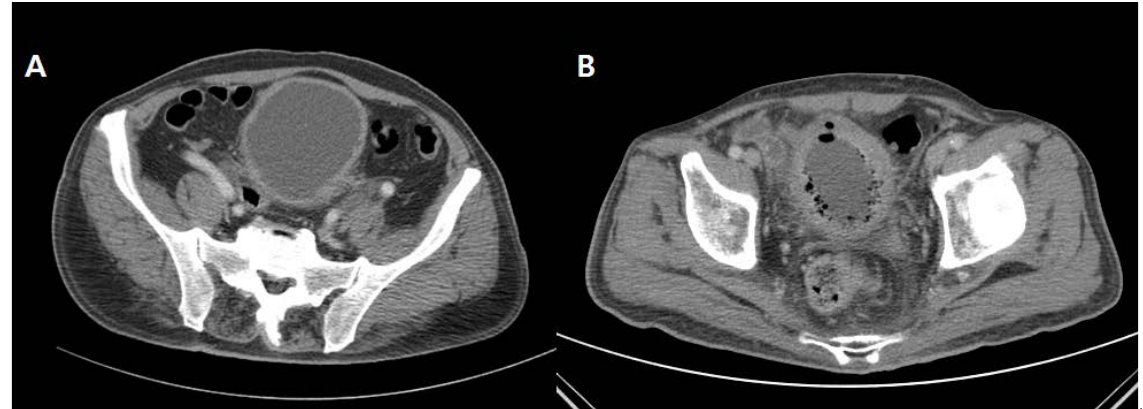
Figure 1. Axial computed tomography (CT) image through the lower pelvis of patients with acute cystitis ( A ) and emphysematous cystitis ( B ), with diffuse bladder wall thickening shown in the bladder of the patient with acute cystitis and gas collection within the bladder wall and lumen in the patient with emphysematous cystitis.